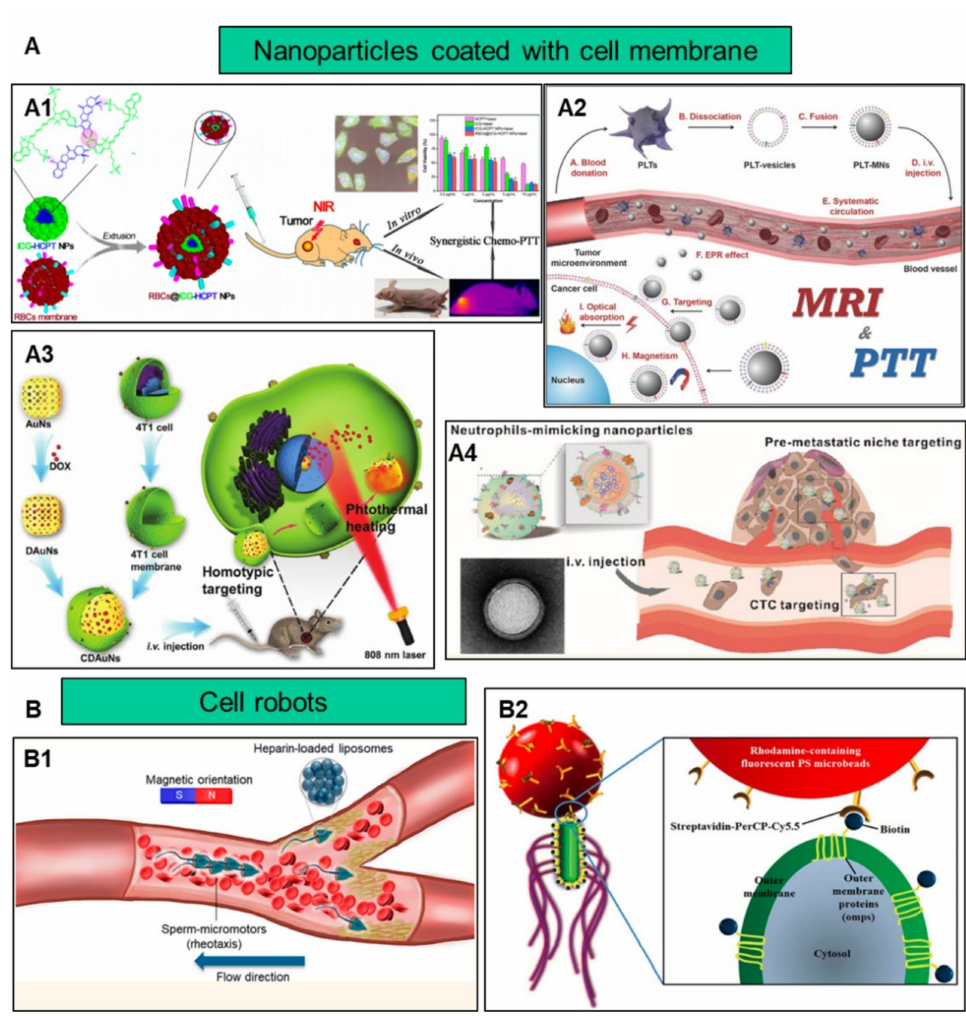
Figure 2. Illustrations of nanoparticles coated with cell membrane and cell robot for improving the targeting efficiency. ( A ) Nanoparticles coated with cell membrane. ( A1 ) Light/pH-triggered biomimetic red blood cell membrane–camouflaged small molecular drug assemblies for imaging- guided combinational chemo-photothermal therapy. Adapted with permission [7]. Copyright ACS Appl Mater, 2019. ( A2 ) Antitumor platelet-mimicking magnetic nanoparticles. Adapted with permis- sion [8]. Copyright Advanced Functional Materials, 2017. ( A3 ) 4T1 cancer cell membrane–coated gold nanocage for the hyperthermia-triggered release of DOX and homotypic targeted therapy of breast tumor growth and metastasis. Adapted with permission [9]. Copyright Advanced Functional Materials, 2017. ( A4 ) Nanoparticles coated with neutrophil membranes can effectively treat cancer metastasis. Adapted with permission [10]. Copyright ACS Nano, 2017. ( B ) Cell robots. ( B1 ) Sperm micromotors for cargo delivery through flowing blood. Adapted with permission [11].